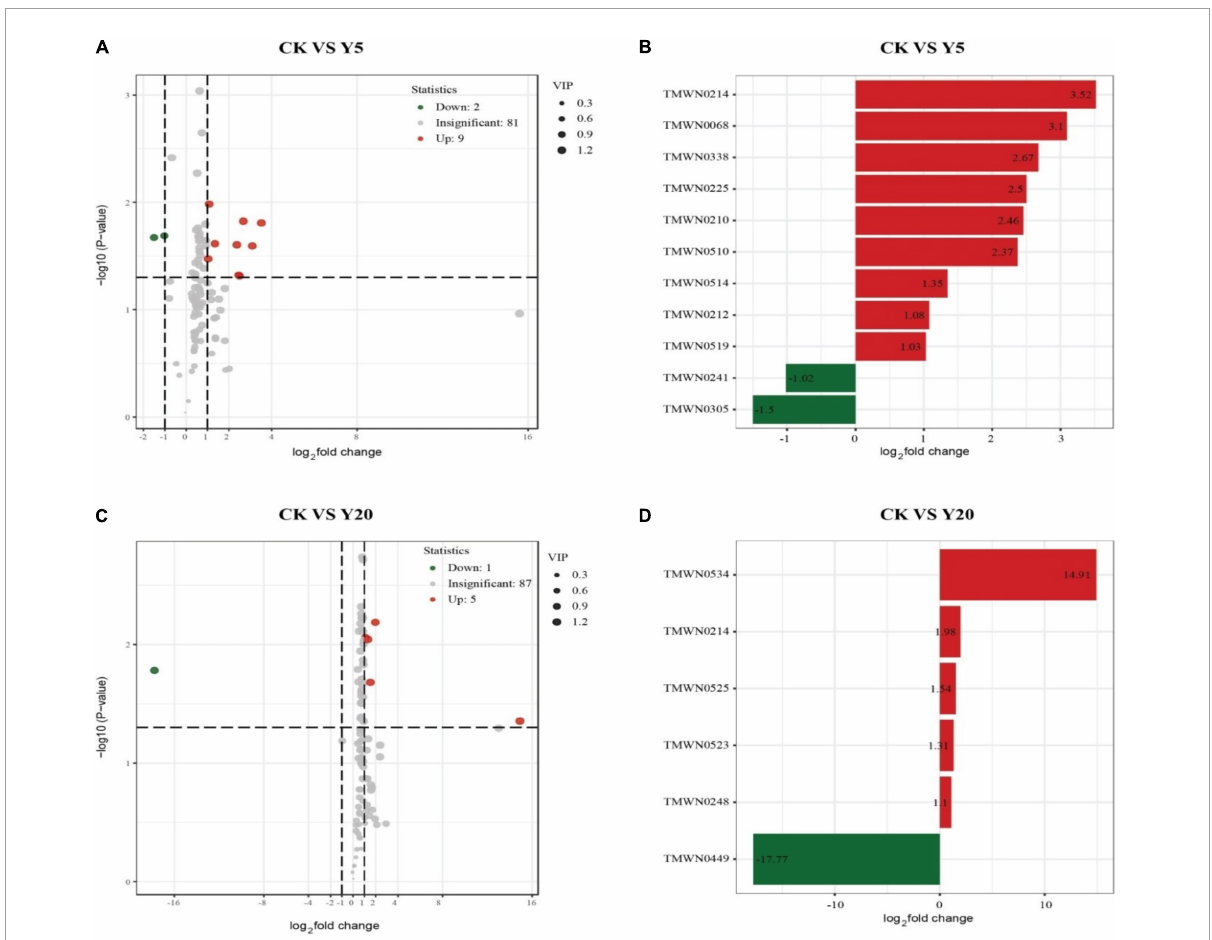
FIGURE5 A volcano map (A,C) , the abscissa indicates the changes in the expression of multiple metabolites in different groups: (A,B) CK vs. Y5, (C,D) CK vs. Y20 (log2 fold change). The vertical coordinate indicates the differences in the significance level (–log10p). Each point in the volcano chart represents a metabolite, the significantly upregulated metabolite is represented by a red dot, and the significantly downregulated metabolite is represented by a green